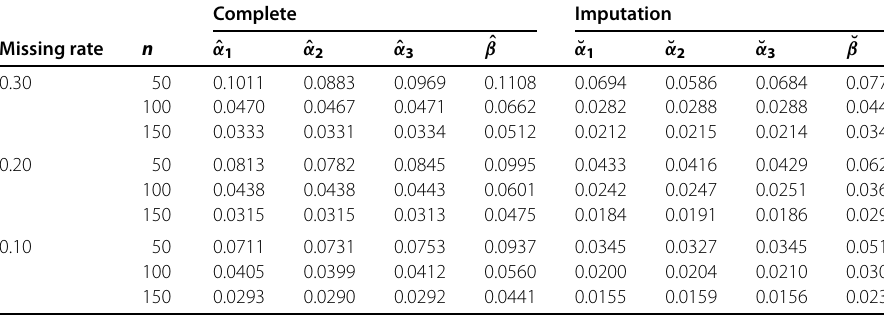
Table 2 Standard errors of α and β under different missing functions and different sample sizes obtained by two different methods for the simulated data Complete Imputation Missing